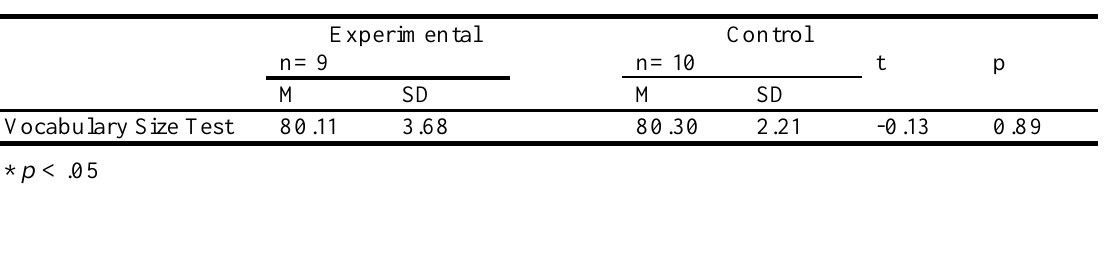
Table 1 Vocabulary Size Test in the Experimental and Control Groups Experimental Control